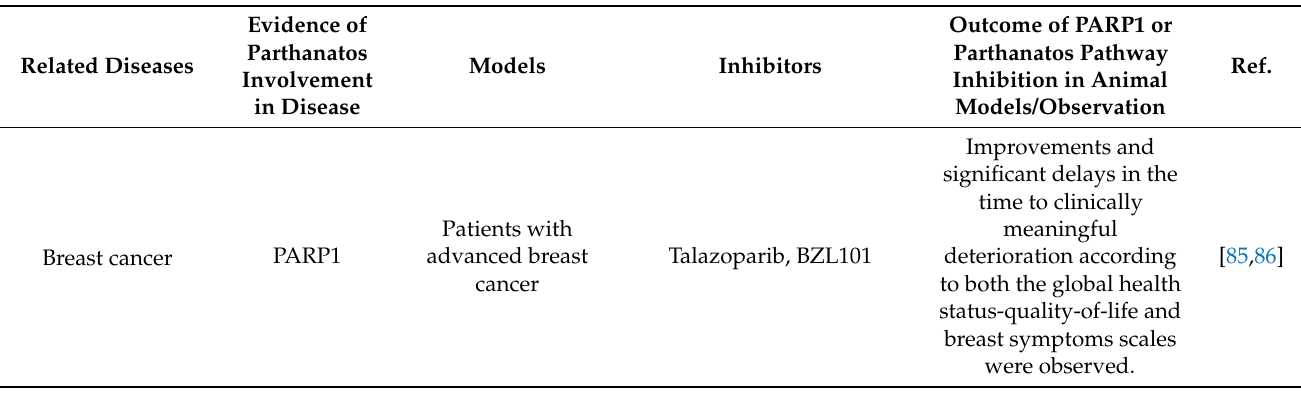
Table 2. Summary of parthanatos in animal/human models of human pathological conditions of related